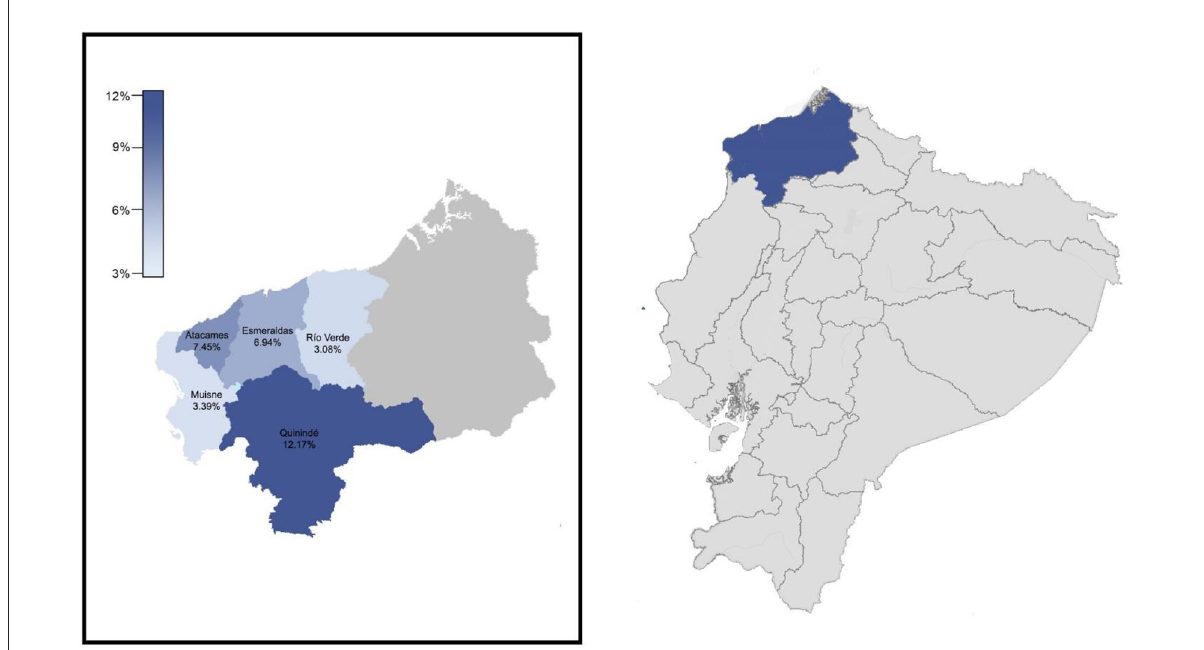
FIGURE1 Location of esmeraldas province within ecuador. Cantons included in the surveillance carried out during October 2020 and their severe acute respiratory syndrome coronavirus 2 (SARS-CoV-2) infection rates by RT-qPCR.